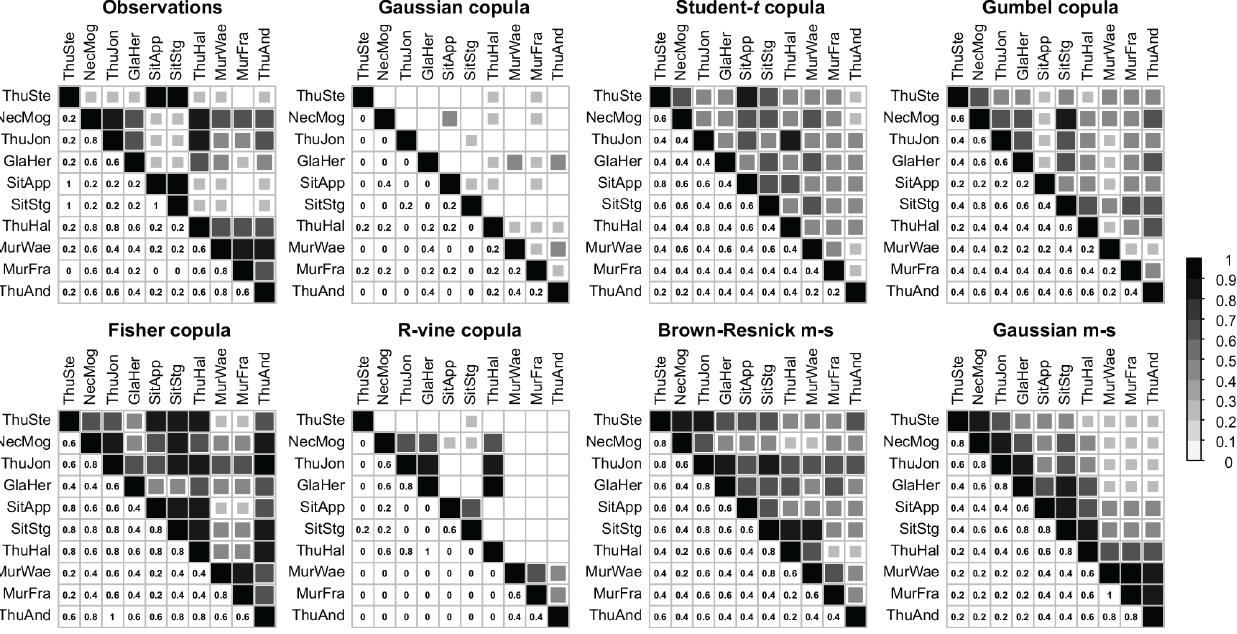
Figure 9. Upper tail dependence matrices for the observations and the event samples generated by different types of dependence models. The darker the color, the stronger the